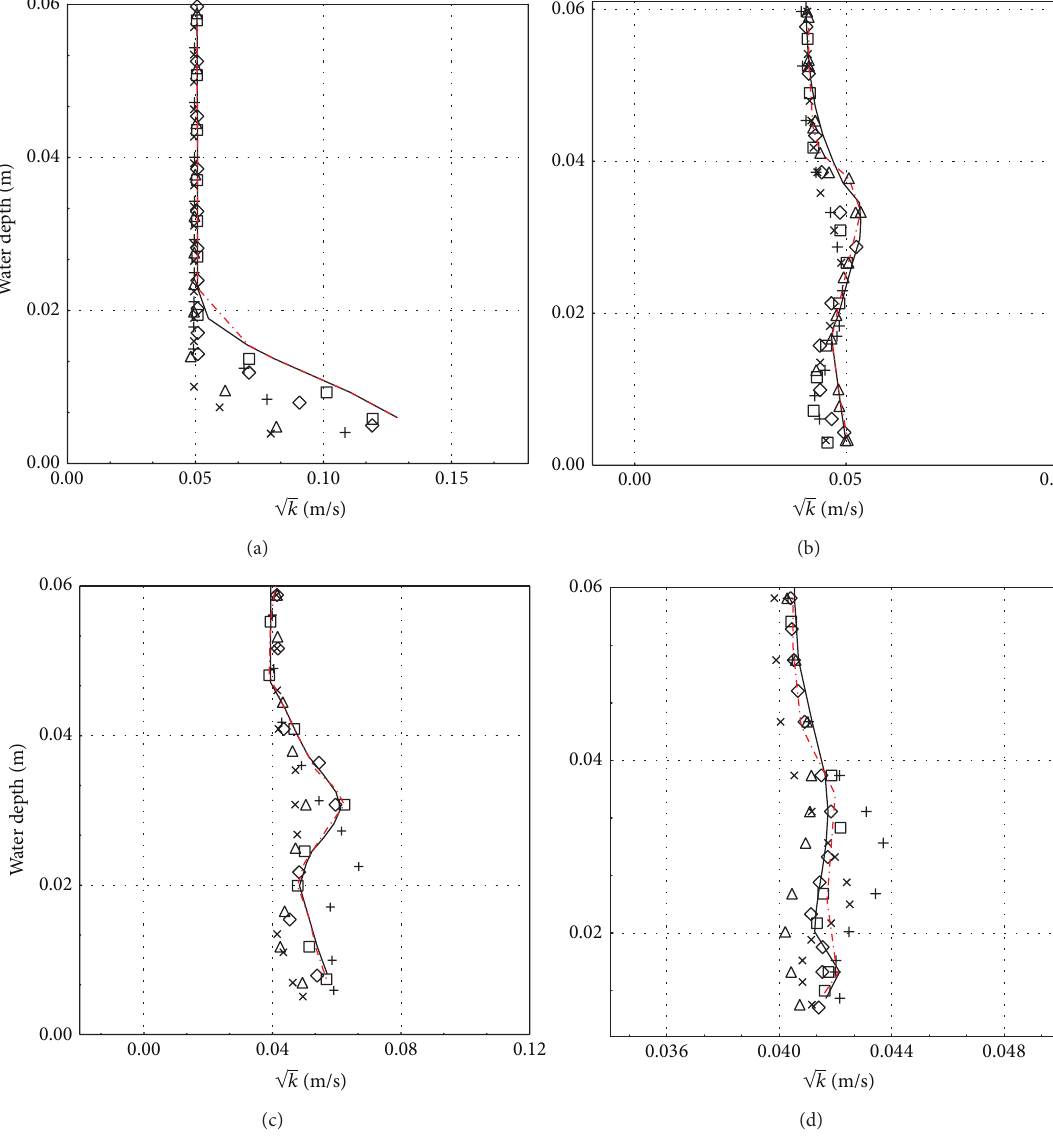
Figure 6: Turbulent kinetic energy square root ( √𝑘 ) at different locations, (a) 𝑋/𝐷 = −3.0 , (b) 𝑋/𝐷 = 1.0 , (c) 𝑋/𝐷 = 1.5 , and (d) 𝑋/𝐷 = 2.0 , — standard 𝑘 - 𝜀 , ⬦ RNG 𝑘 - 𝜀 , △ realizable 𝑘 - 𝜀 , × standard 𝑘 - 𝜔 , + SST 𝑘 - 𝜔 , and ◻ Reynolds stress model (RSM), Red